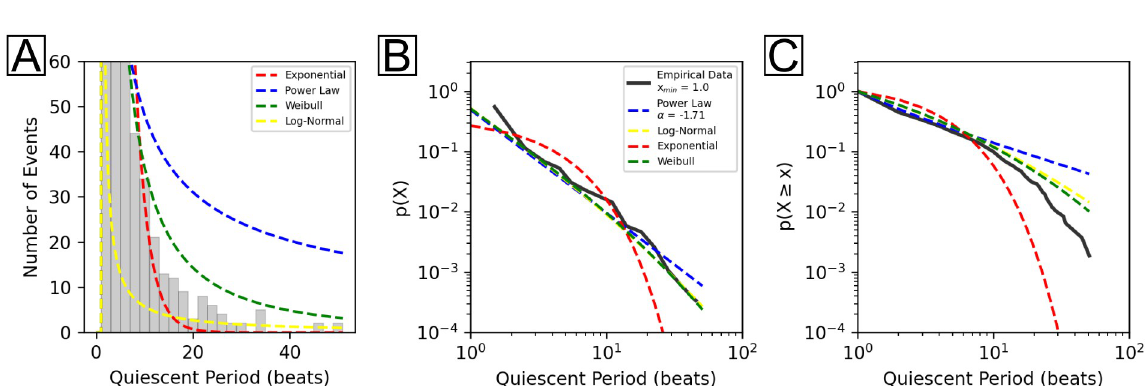
Fig 5. Comparisons between heavy-tailed probability distributions. A) Histograms and fitted PDFs of power law (blue, solid), log-normal (yellow, dashed line), exponential (red, dashed line), and Weibull (green, dashed line) probability distributions for all quiescent periods. B) Empirical data (black, solid line) plot overlaid with PDFs of power law (blue, dashed line), log-normal (yellow, dashed line), exponential (red, dashed line) and Weibull (green, dashed line) distributions. C) Empirical data plot overlaid with complementary cumulative distribution functions (CCDFs) of power law, log-normal, exponential, and Weibull distributions. The empirical x min , or minimum cutoff value, value was determined algorithmically by the powerlaw library. Calculated parameters for each distribution are summarized in Table 1. Residual plots for the data from B and C are shown in S1